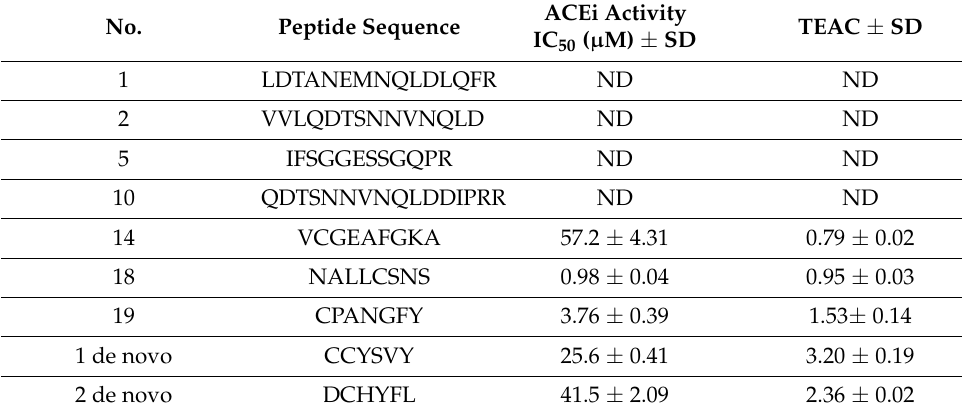
Table 7. ACE-inhibitory activity and ABTS radical antioxidant capacity of a selection of synthetic peptides detected in virgin olive oil. Peptide nos. 1, 2, 5, 10, 14, 18 and 19 were identified by Peaks DB algorithm; peptide nos.1 de novo and 2 de novo were identified by Peaks de novo sequencing algorithm: ACEi activity, angiotensin-converting enzyme inhibitory activity; IC 50 ( µ M), peptide concentration necessary to inhibit 50% of ACE activity, expressed in µ M. Antioxidant activity is referred to Trolox and expressed as TEAC (Trolox Equivalent Antioxidant Capacity). Data are means ± SD of three different experiments. ND, not